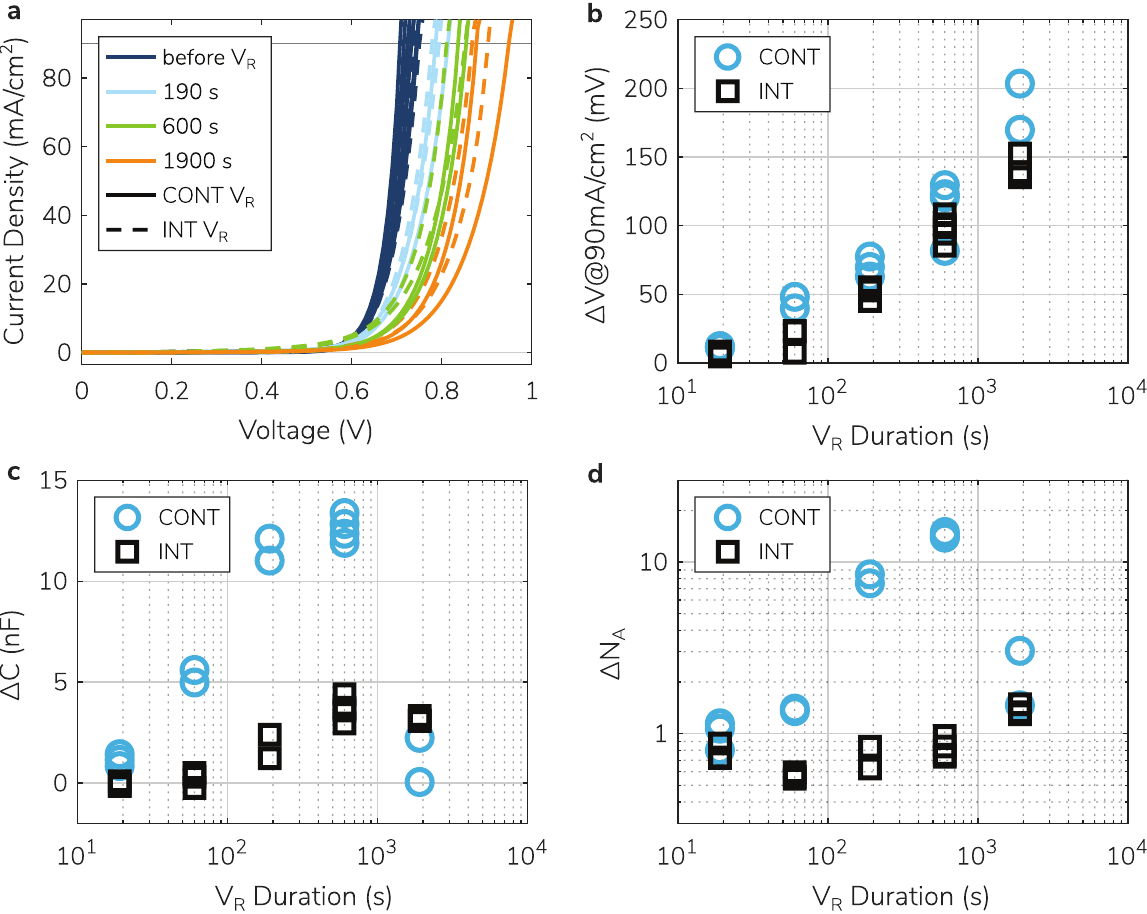
Fig. 6. Metastable changes due to reverse-bias ( V R ) treatments in the dark (2 – 4 samples per condition). (a) IV characteristics before (dark blue) and after continuous (solid lines) and intermittent (dashed lines) V R treatments of different durations (colour-coded). (b) Shift of the voltage at 90 mA/cm 2 (see grey line in a), (c) shift in capacitance at 0V, and (d) shift in doping density (ratio: D N : ¼ ࣎ N after = N before A A A ) after reverse-bias treatments of different durations ( intermittent: